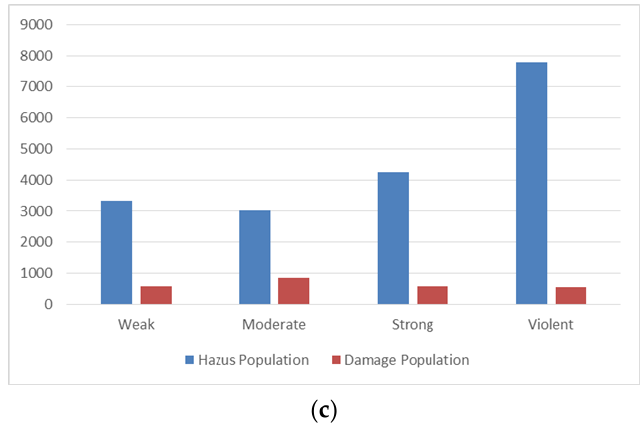
Figure 15. The populations (in units of a thousand) covered by each class in our estimated damage map and FEMA HAZUS loss model map for the ( a ) Naive Bayes, ( b ) SVM, and ( c ) deep learning algorithms.